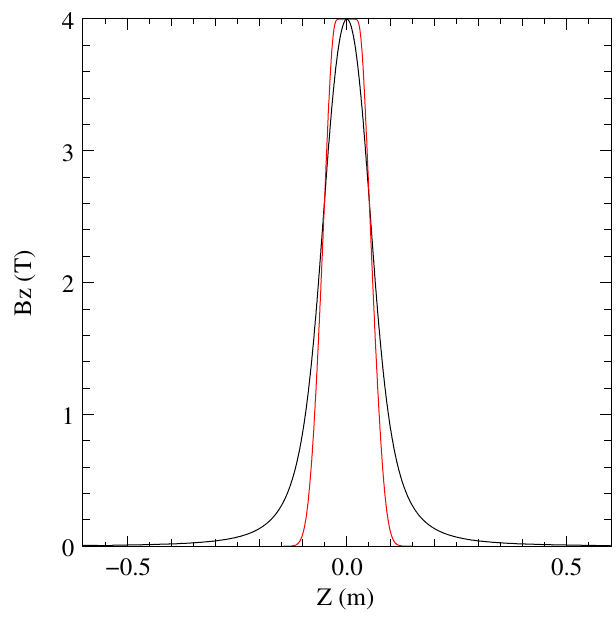
FIG. 1. The two longitudinal profiles of the solenoid field used in the simulations. The black is the profile that is mostly fringed, and the red is closer to a hard edge.